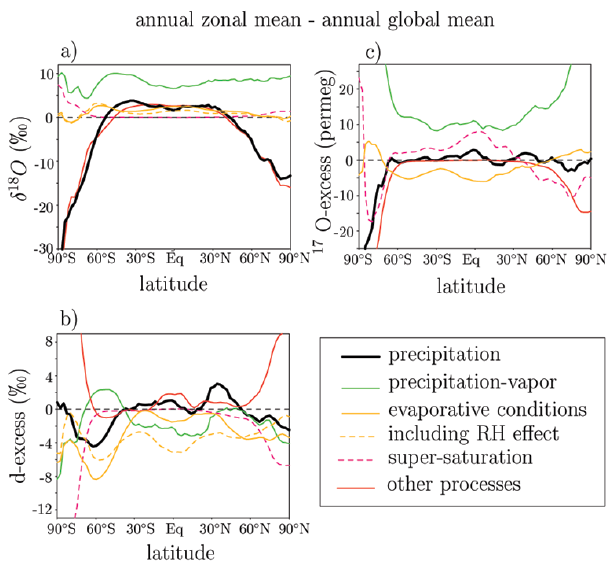
Fig. 8. Decomposition of the annual zonal mean distribution of the precipitation δ 18 O, d-excess and 17 O-excess into different contribu- tions. The black line correspond to the total simulated values. The green, orange, dashed pink and red correspond to the precipitation- vapor difference, the effect of evaporative conditions (SST and RH s ), the effect of supersaturation and all other effects, respectively. Their sum makes the total black line. The effect of evaporative con- ditions is further decomposed into the effect of RH s only (dashed orange). The difference between the solid and dashed orange lines correspond to the effect of SST only. To focus on spatial patterns, we subtract the annual, global mean to all curves. When the black curve is positive, δ 18 O, d-excess or 17 O-excess are higher than the global mean. When the colored curves are positive, the correspond- ing process contributes to increase the total values. When the col- ored curves show a similar shape as the black curve, they contribute to the latitudinal variations of the total signal.